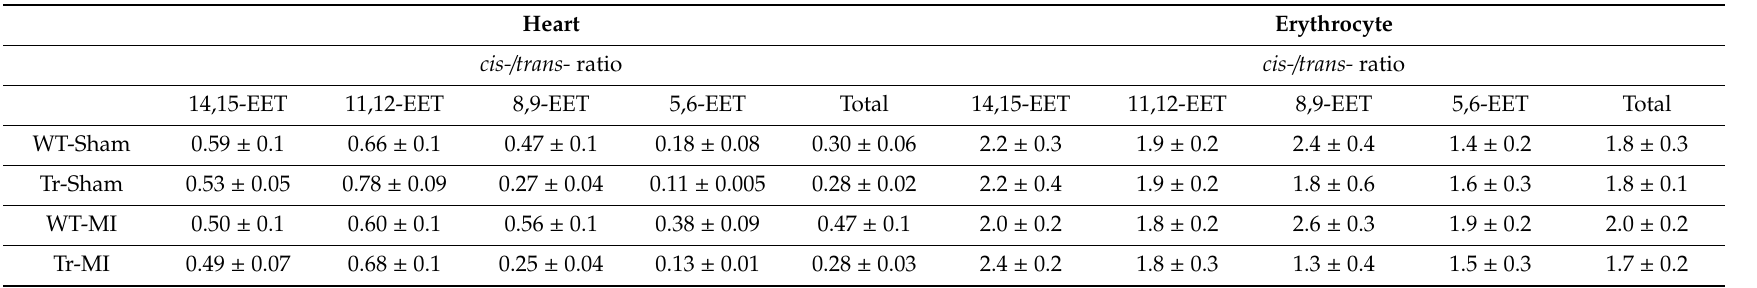
Table 1. Summary of geometric isomers of individual regioisomer of EETs in cardiac tissue and erythrocyte membrane of WT and Tr mice subjected to sham or MI surgery. There were eight WT mice (4 female and 4 male) and nine Tr mice (5 female and 4 male) subjected to sham surgery and nine WT mice (4 female and 5 male) and nine Tr mice (4 female and 5 male) subjected to MI